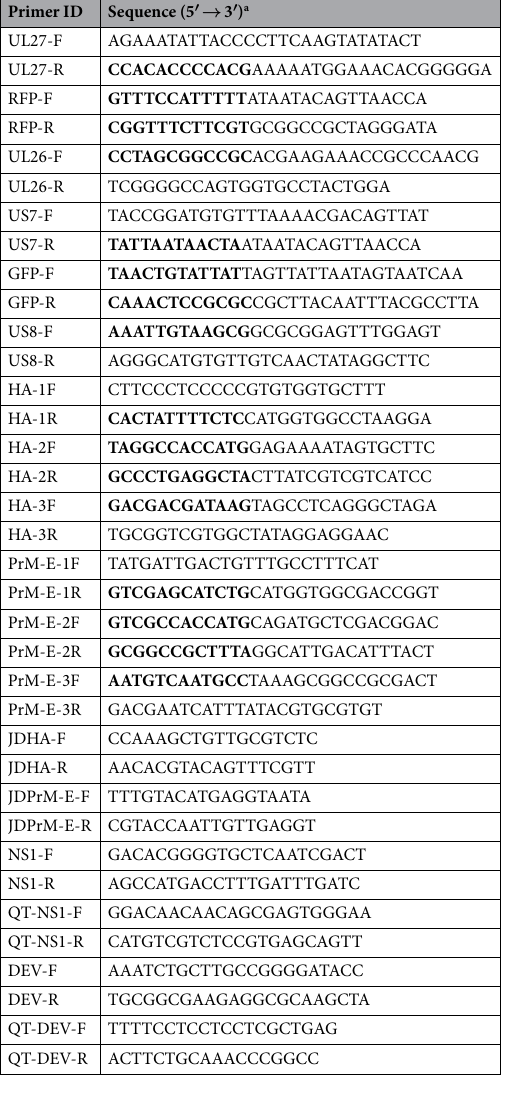
Table 2. Primers used for generating C-KCE-HA/PrM-E, identification of the C-KCE-HA/PrM-E, and determination the DTMUV load. a The overlap sequences are marked in